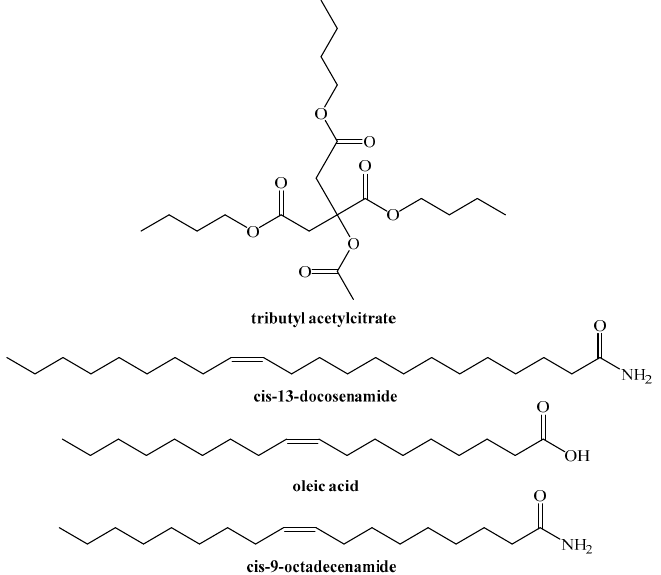
Figure 2. Chemical species detected by GC − MS both in L. occidentalis eggs and egg glue.